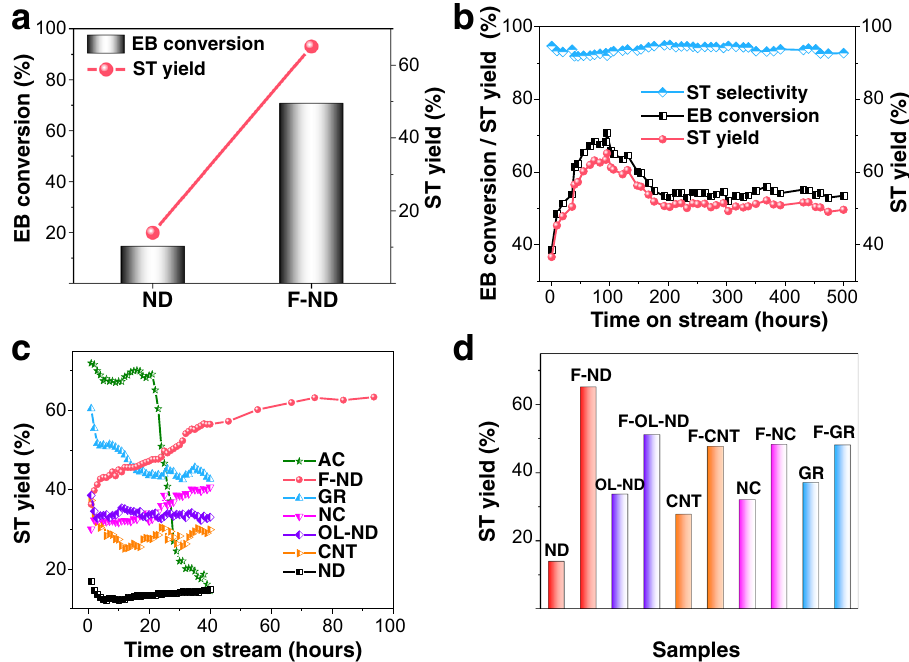
Fig. 2 ODH activities of EB to ST for various carbon-based catalysts. a The performance of ND and F-ND catalysts for ODH reactions. b Stability of F-ND catalysts for ODH reactions over a 500 h test. c Stability of carbon-based catalysts for ODH reactions over 40 h test. d The optimized performance of fl uorinated carbon-based catalysts for ODH reactions. Reaction conditions for all the experiments: 20 mg catalysts, 470 nmol mL − 1 EB with N 2 balance, O 2 : EB = 3:1, total fl ow rate = 10 mL·min − 1 , T = 400 °C. AC active carbons. GR graphene. NC nanocarbons. OL-ND onion-like nanodiamonds. CNT carbon